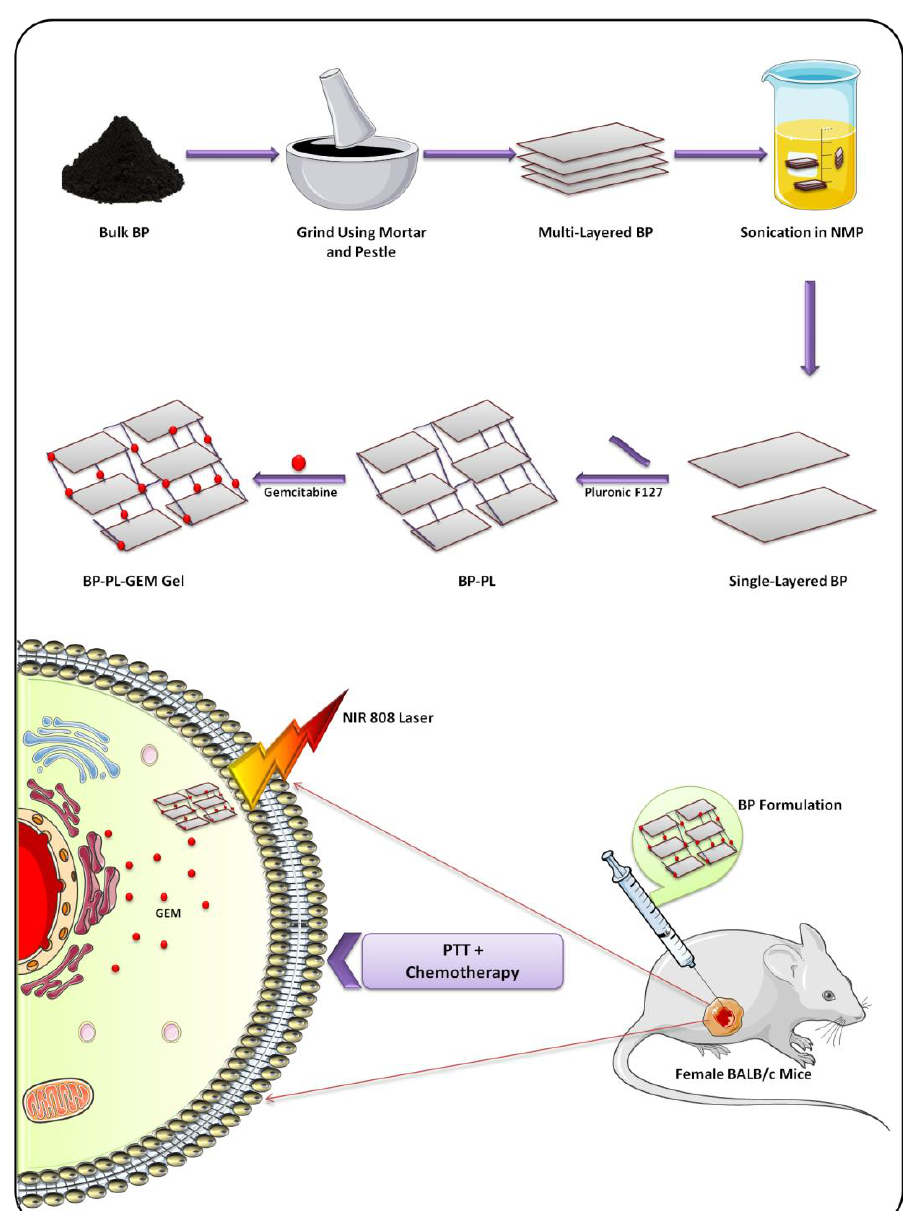
Figure 7. Loading of GEM to the BP nanosheets and combined phototherapeutic activity of the formulation.